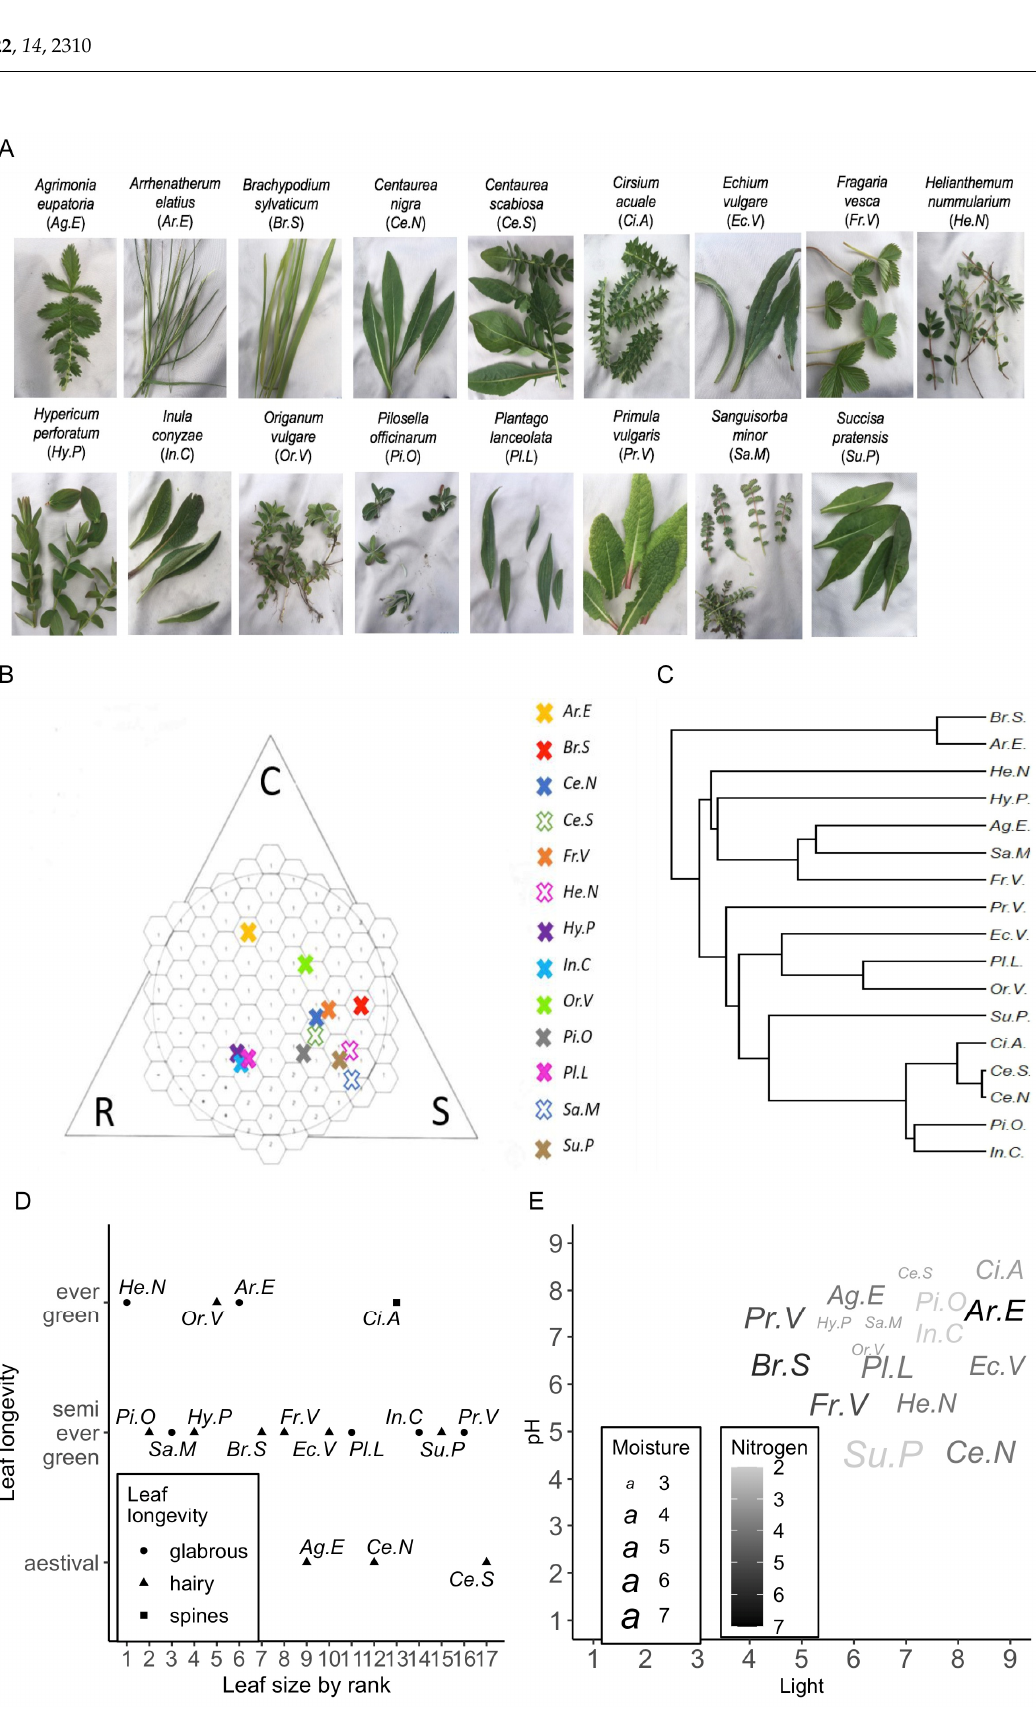
Figure 1. ( A ) The 17 grassland species that were involved in this study; ( B ) a plot of 13 of those species within the Grime strategy space, where data were available; ( C ) the phylogenetic relationship between species; ( D ) the morphological and phenological characteristics of the leaves; ( E ) Ellenberg’s indicator values for light, moisture, pH and